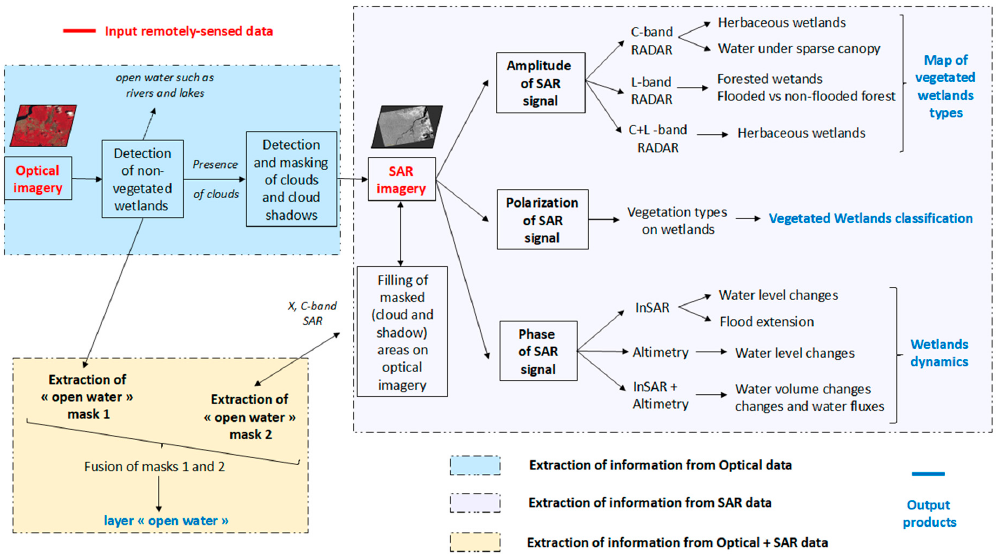
Figure 5. Proposed framework for the characterization and mapping of wetlands and water collections by combining optical and SAR remotely sensed data.